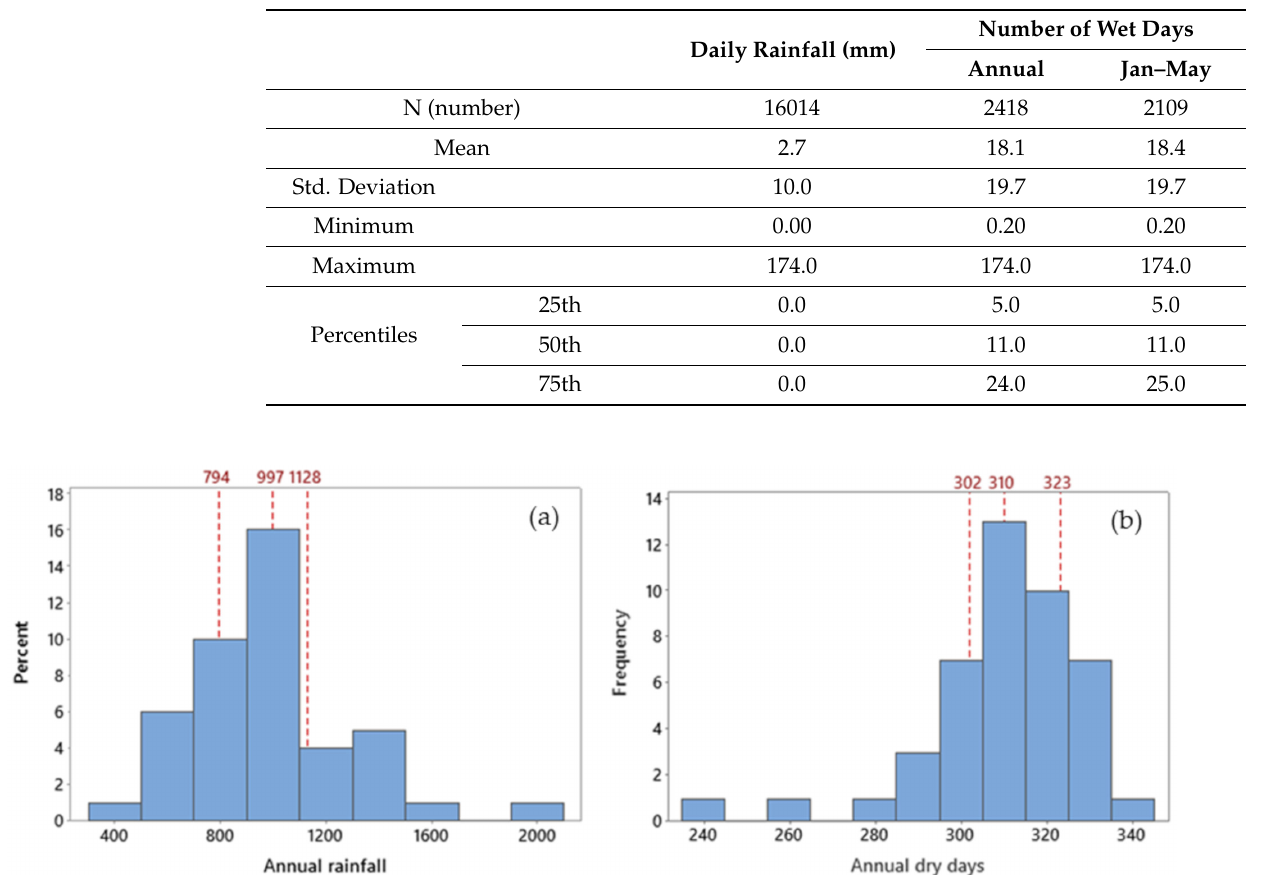
Table 2. Characteristics of daily rainfall at Iguatu, CE, Brazil (1974–2017).